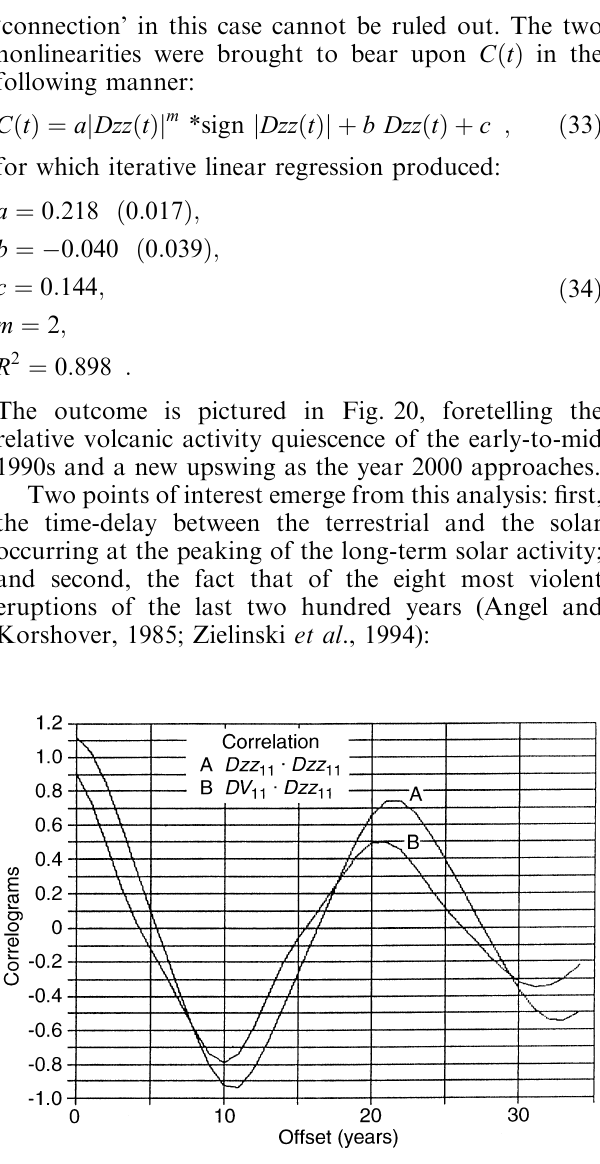
Fig. 19. Volcanic and solar cross-correlations